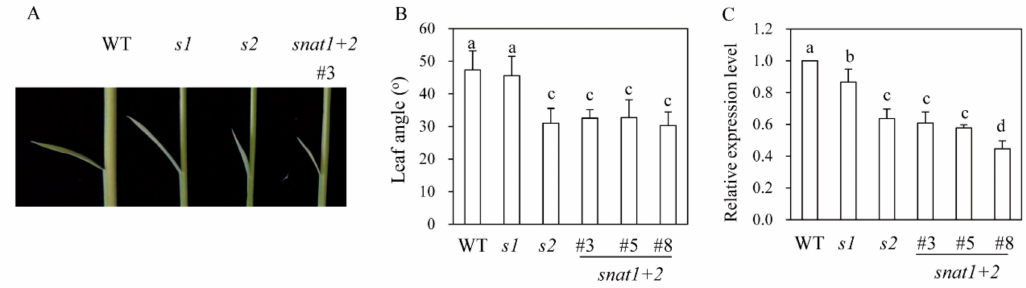
Figure 4. Measurements of second leaf angles and DWARF4 expressions. ( A ) Photograph of representative transgenic rice plants. ( B ) Leaf angle measurements ( n = 10). ( C ) Relative expression levels of DWARF4